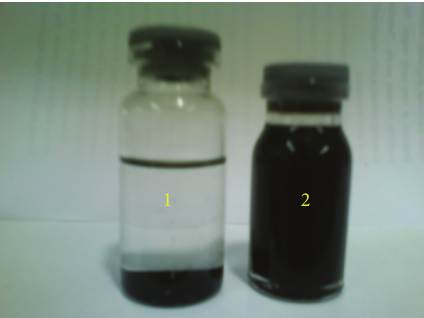
Figure 6: The dispersion images of Sh-MWCNT-COOH (1) and Sh- MWCNT-Spiro (2) in DMF (1mg/7mL) after standing for 4 month.